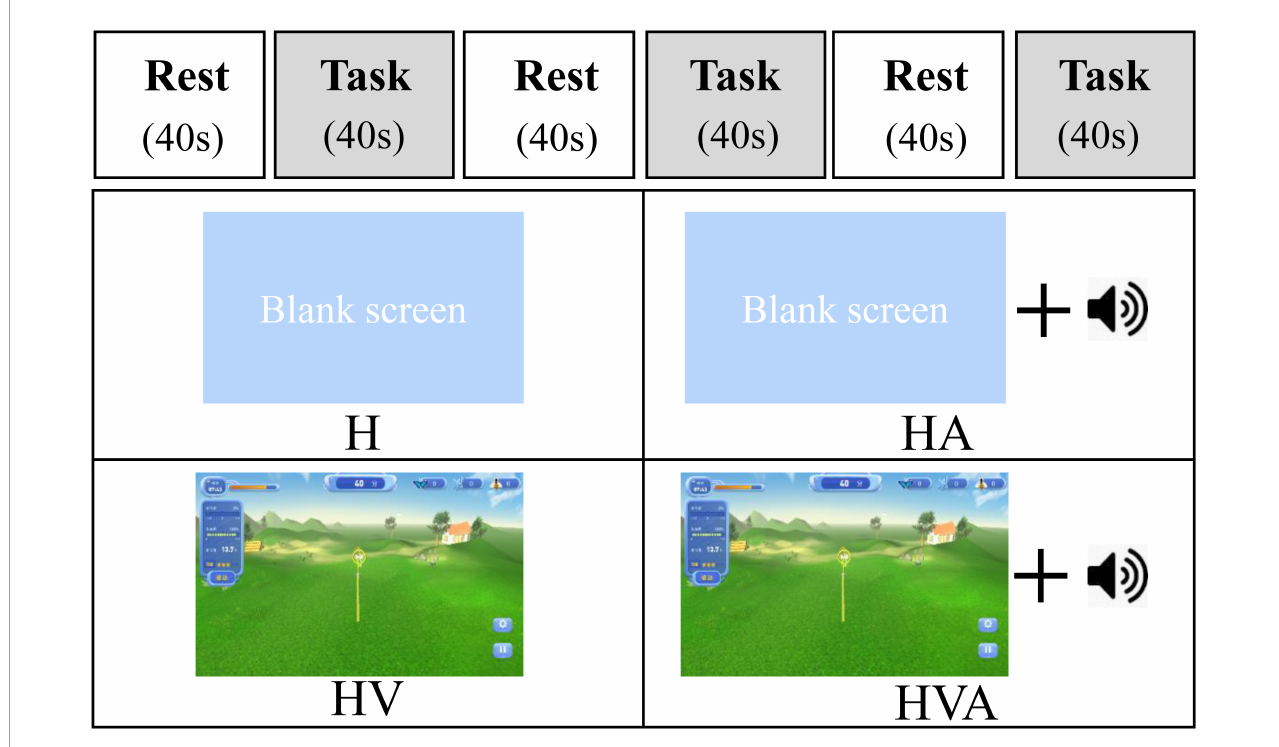
FIGURE3 The experimental paradigm and the four different virtual reality (VR) training modes. The patients performed four cycling tasks, each starting with a 40 s rest period and a 40 s training period, which was repeated three times. The abbreviations in the figure represent haptic (H), haptic + auditory (HA), haptic + visual (HV), and haptic + visual + auditory